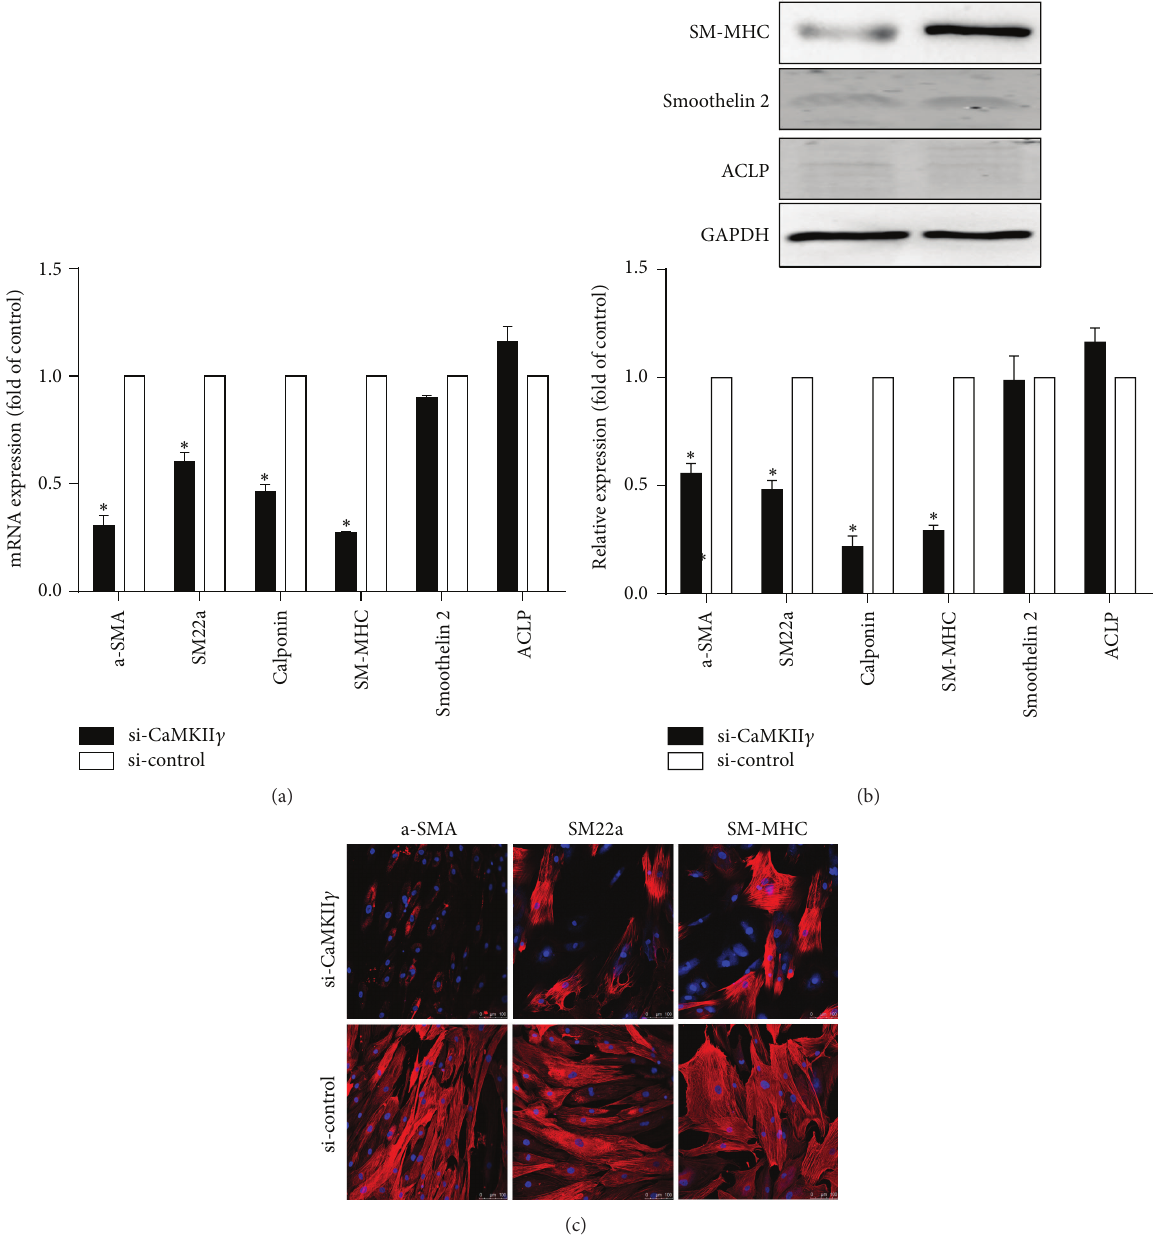
Figure 5: Expression of smooth muscle contractile markers was downregulated in induced hASCs transfected with siRNA against CaMKII 𝛾 . (a) Expression of smooth muscle contractile markers in si-CaMKII 𝛾 and si-control group determined by qRT-PCR. Data represent means ± SE, 𝑛 = 3 ( ∗ 𝑃 < 0.05 versus si-control). (b) Western blot analysis of smooth muscle contractile proteins in si-CaMKII 𝛾 and si-control group, respectively. Data represent means ± SE, 𝑛 = 3 ( ∗ 𝑃 < 0.05 versus si-control). (c) Immunofluorescent staining of a-SMA, SM22a, and SM-MHC (red) in si-CaMKII and si-control group, respectively. Nuclear were stained with DAPI (blue). Scale bars: 100 𝜇